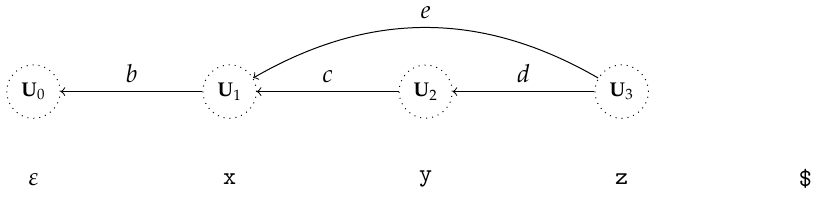
Figure 14. Zoomed-out view of the GSS for the specification Ξ in (3) only displaying the edges resulting from shift